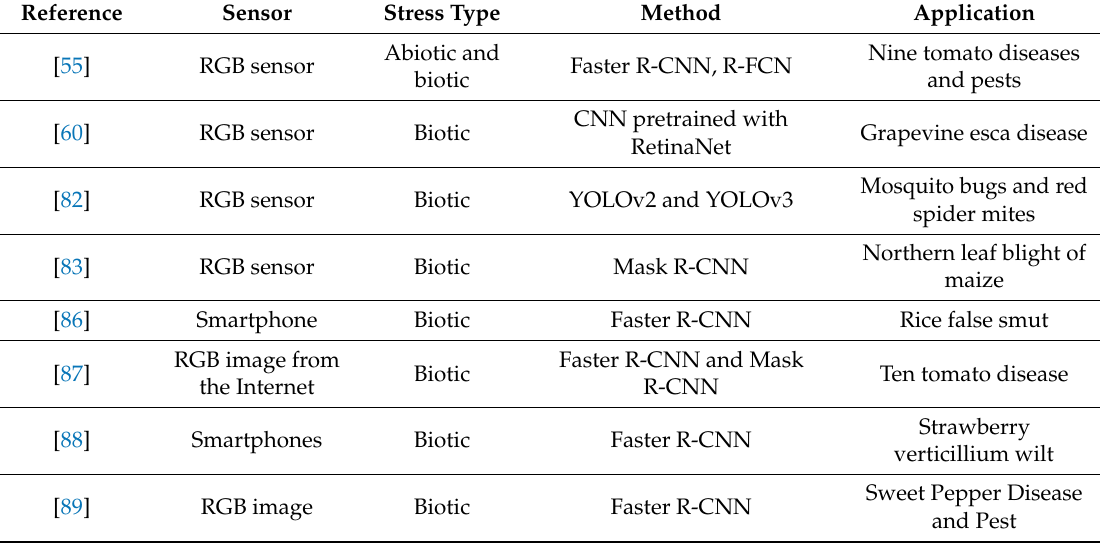
Table 3. Application of deep learning for crop stress object